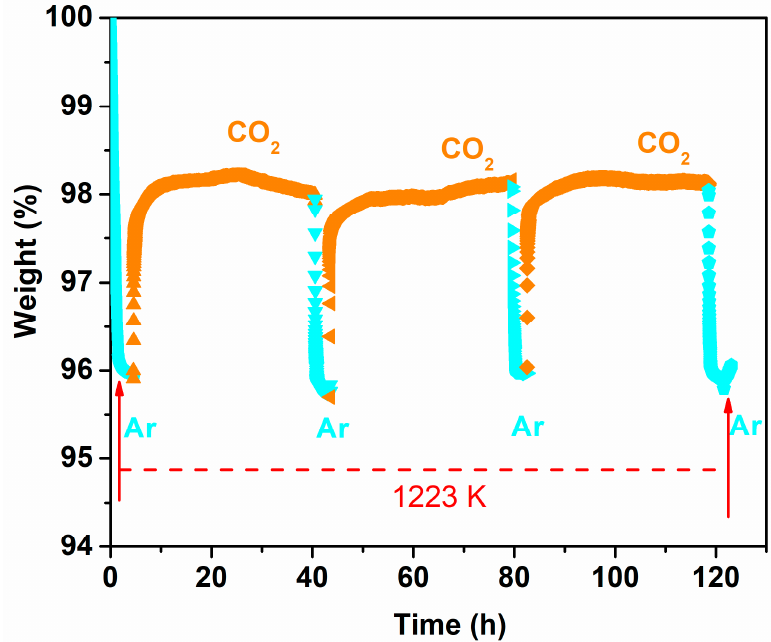
Figure 11. TG curve of the Ce 0.9 Pr 0.1 O 2 − δ –Nd 0.5 Sr 0.5 Fe 0.9 Cu 0.1 O 3 − δ dual-phase powder material while periodically changing the gas atmosphere between Ar and CO 2 at 1223 K. Table 1. Summary of the reported promising oxygen permeation fluxes of various dual-phase membranes.